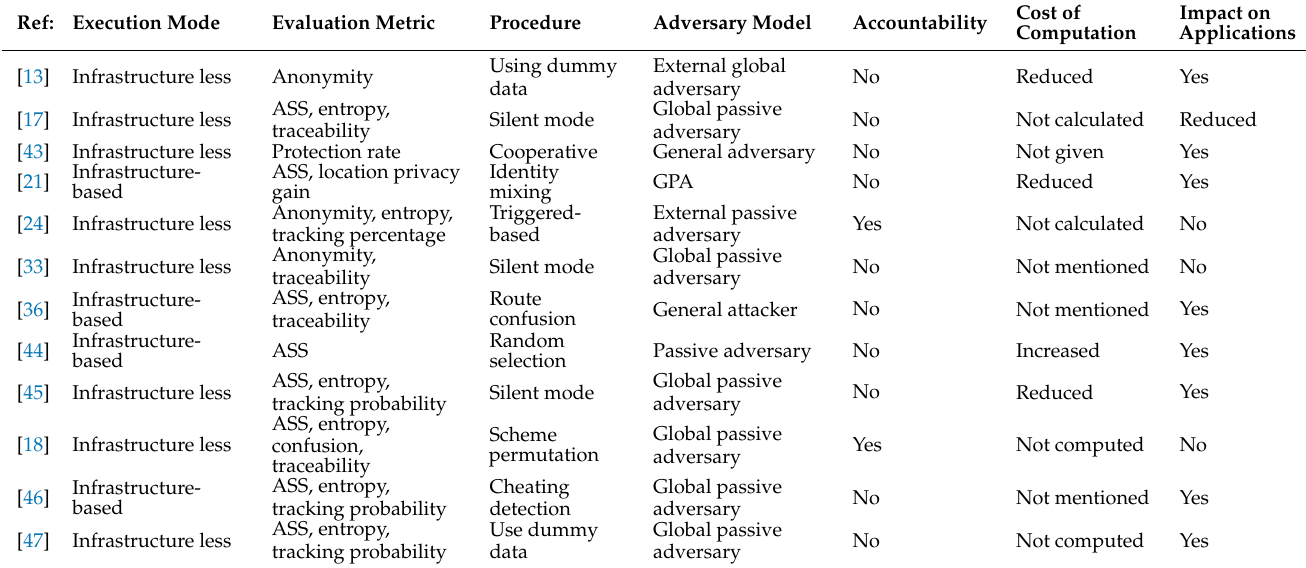
Table 1. Comparative analysis of existing location privacy